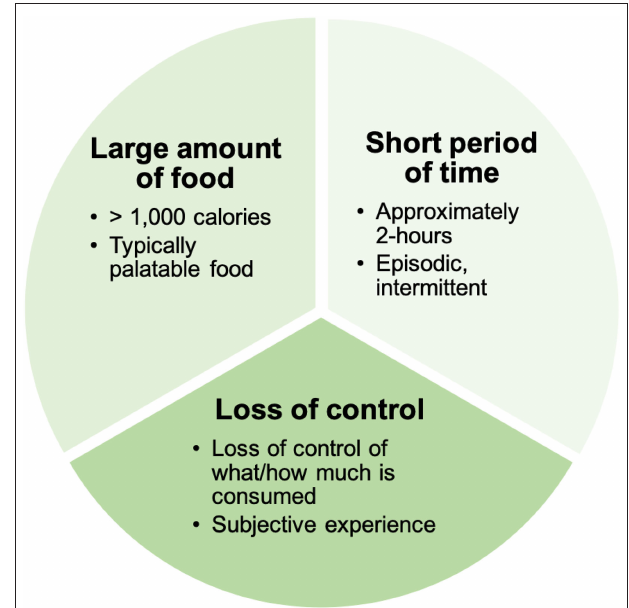
FIGURE 2 | Clinical components of binge eating. Binge eating is comprised of three core clinical components: (1) The consumption of a large amount of food (that is typically palatable in nature). (2) The consumption of food is episodic and occurs within in a short period of time. (3) Individuals experience a loss of control over what and/or how much they are eating during binge eating